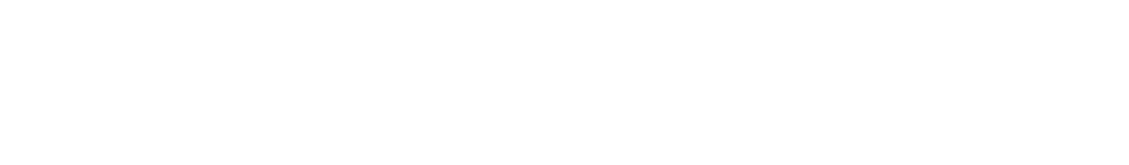
Frontiers in Environmental Science |